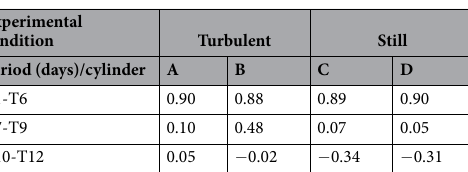
Table 1. Division rates expressed as divisions·day − 1 calculated in the three portions of the growth curves, i.e. the exponential (T1–T6), stationary (T7–T9) and post-exponential (T10–T12) phases. An asterisk indicate that replicates are not statistically different (accuracy